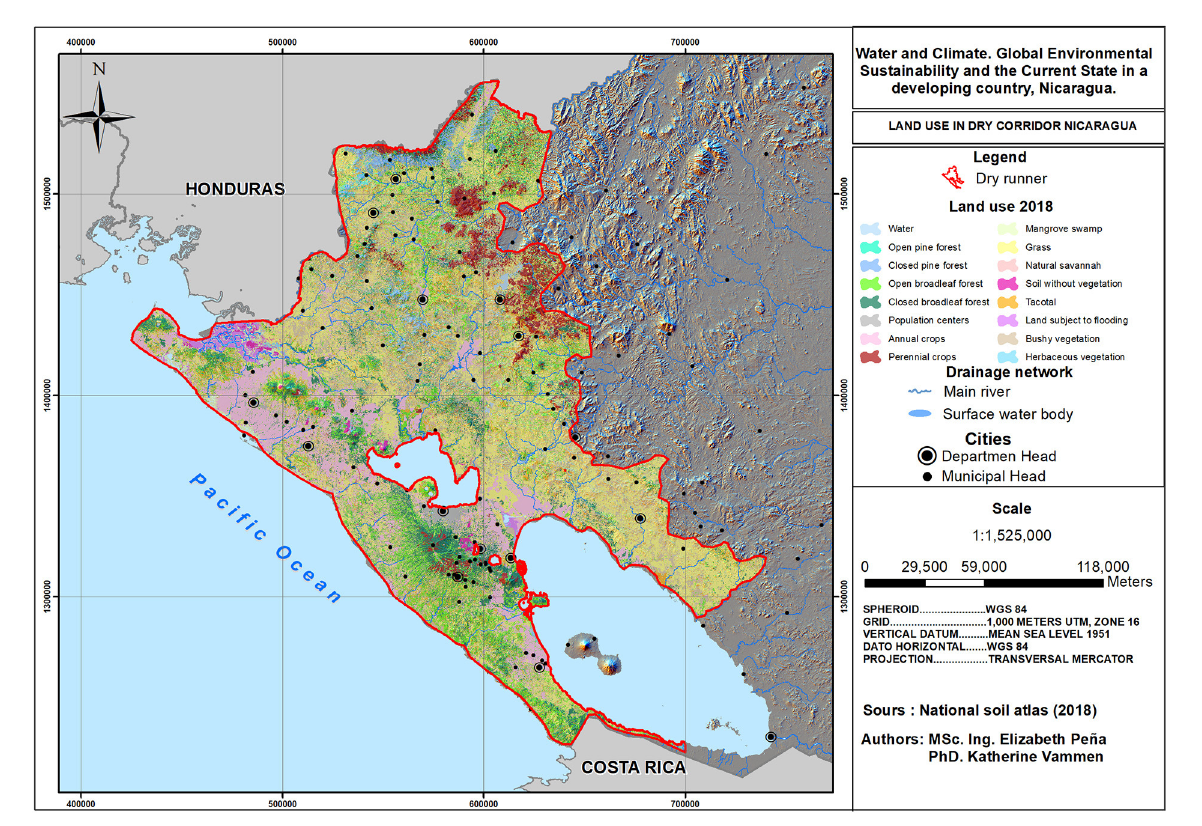
FIGURE6 Present land use of the Dry Corridor of Nicaragua (Prepared by the authors. Source: National Atlas of Soils of the Republic of Nicaragua, 2018-2021, Instituto Nicaraguense de Estudios Territoriales (INETER), 2018).